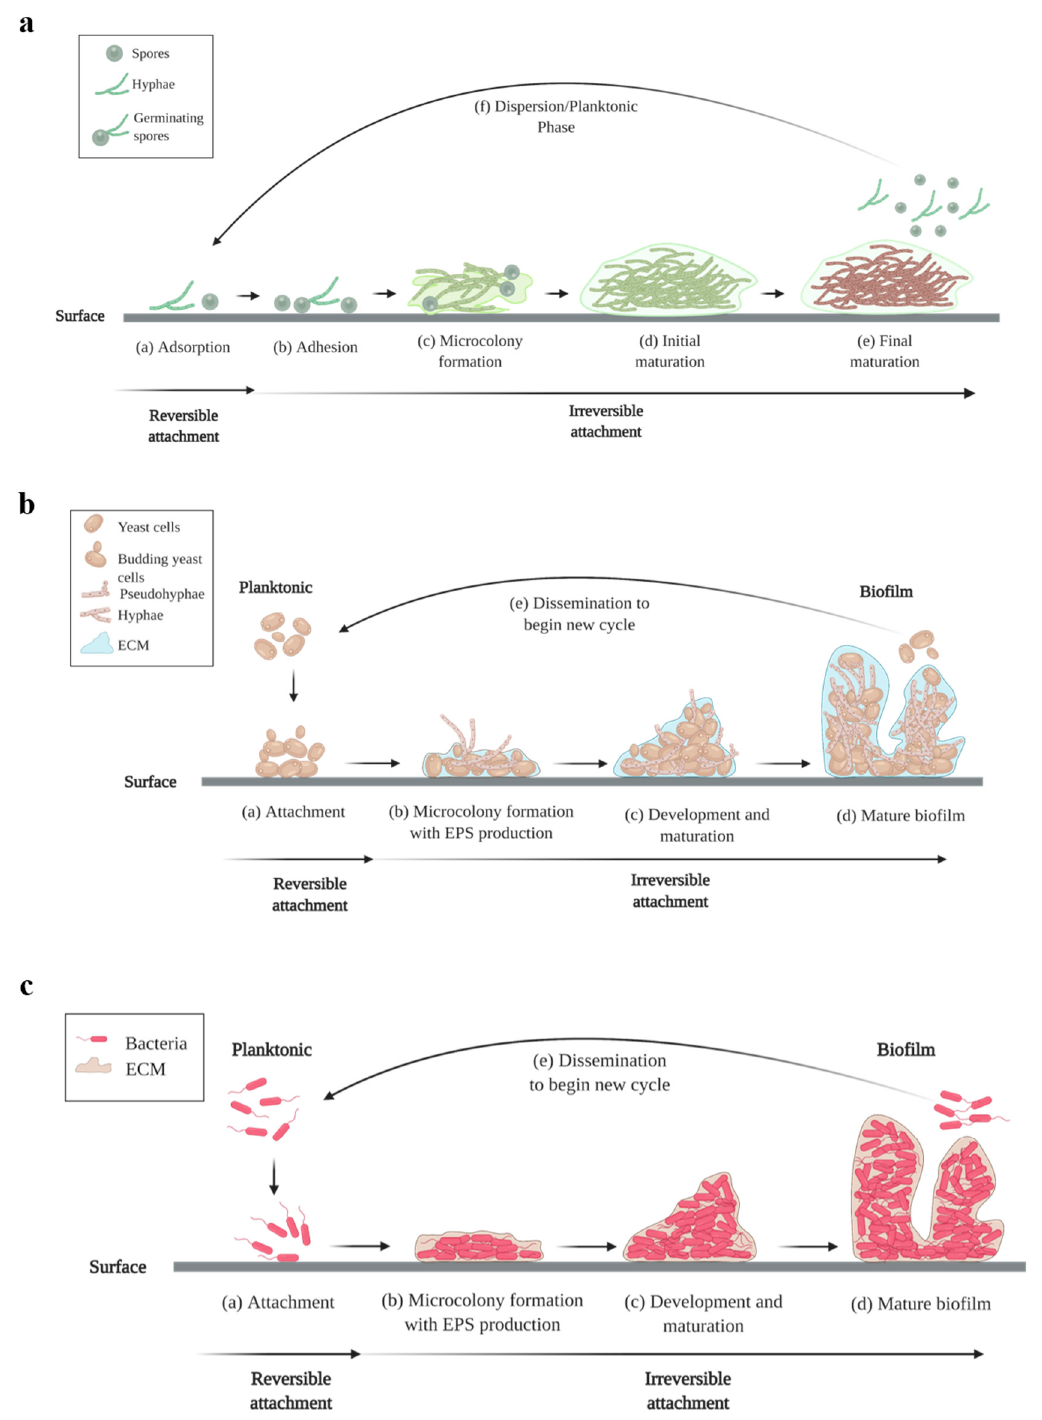
Figure 1. Schematic models of various stages of biofilm development in ( a ) filamentous fungi, ( b ) yeasts, and ( c ) bacteria. Biofilm formation by these three microorganisms share similar processes in terms of their initial attachment to surfaces, the formation of microcolonies, their maturation and dispersal into the surrounding. Initial adhesion is the only reversible step for all these microorganisms.